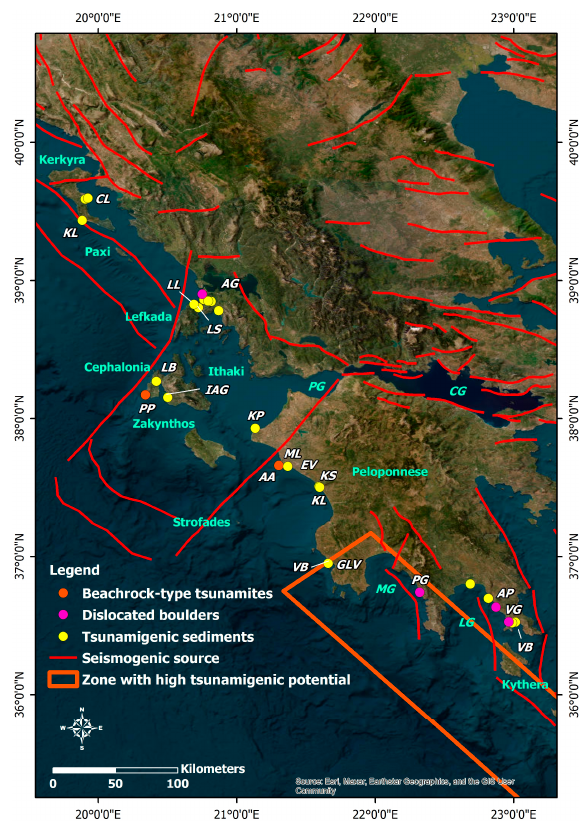
Figure 4. Distribution of tsunami signature on the stratigraphic record of coastal areas affected mainly by distant tsunamigenic prehistoric and historical earthquakes in the western part of Greece. Based on related studies [99–112], the tsunami signature has been classified into: beachrock-type tsunamigenic calcarenites (orange circles), dislocated boulders (purple circles) and tsunamigenic sediments in the stratigraphic record (yellow circles). The seismogenic sources are also presented. They are derived from the Greek Database of Seismogenic Sources (GreDaSS) compiled by Caputo